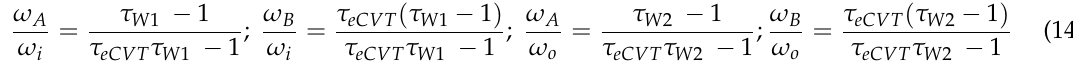
Figure 3. Examples of 𝜏 (cid:3034)(cid:3039) as a function of 𝜏 (cid:3032)(cid:3004)(cid:3023)(cid:3021) in four cases, depending on the minimum and maximum limits.